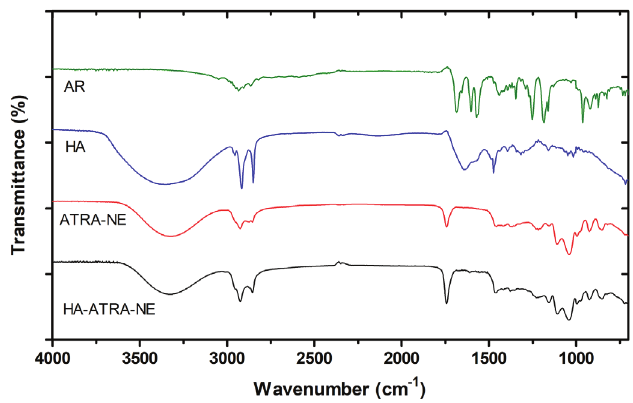
FIGURE 3 – FTIR-ATR spectra of ATRA, HA, coated and non- coated ATRA-loaded